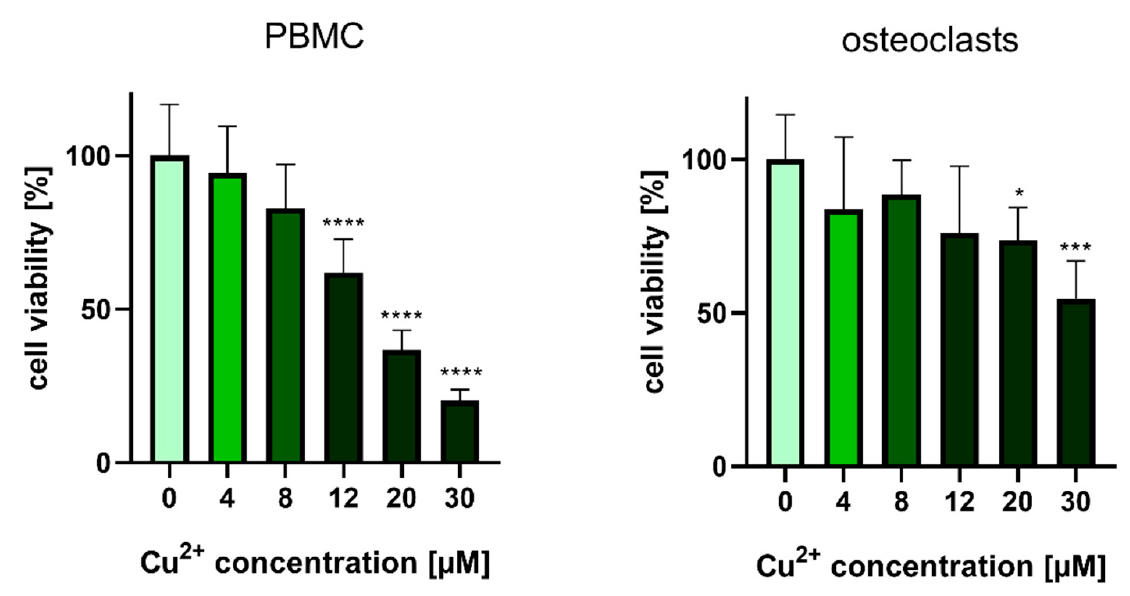
Figure 1. Cell viability of human PBMC and mature human osteoclasts after treatment with Cu 2+ . Luminescence-based CellTiterGlo ® assay was used to determine the ATP content, which correlates with the number of metabolically active cells. Cells of two donors with each n = 3 ( n = 6 in total per group) were included into the experiments. Statistic differences were calculated by one-way ANOVA, followed by Tukey’s test for multiple comparisons * p < 0.05, *** p < 0.001, **** p < 0.0001.